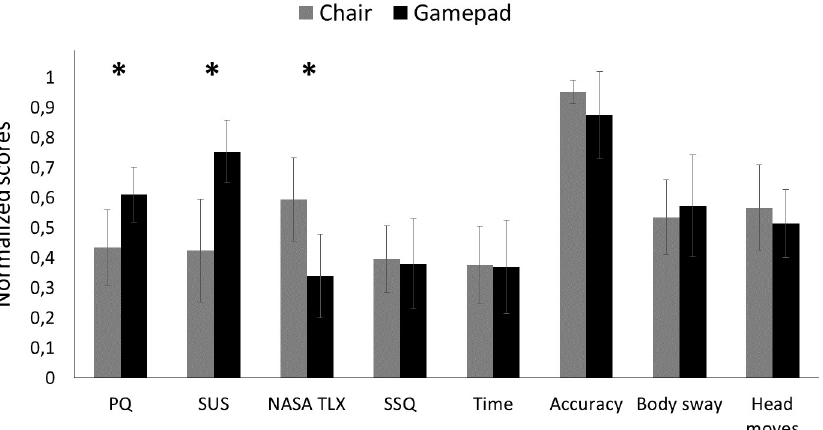
Fig 6. Bar chart of all dependent measures from Experiment 1. For this visualization only, each dependent measure was normalized to a value between 0 and 1 by subtracting the minimum value from each individual value and then dividing by the maximum value. Error bars represent ± 2 standard errors of the mean (SEMs). Asterisks mark a significant main effect of control interface. Larger values are desirable for the presence questionnaire (PQ), system usability scale (SUS), and Accuracy. Smaller values are desirable for workload (NASA TLX), simulator sickness questionnaire (SSQ), Time, and Body sway.